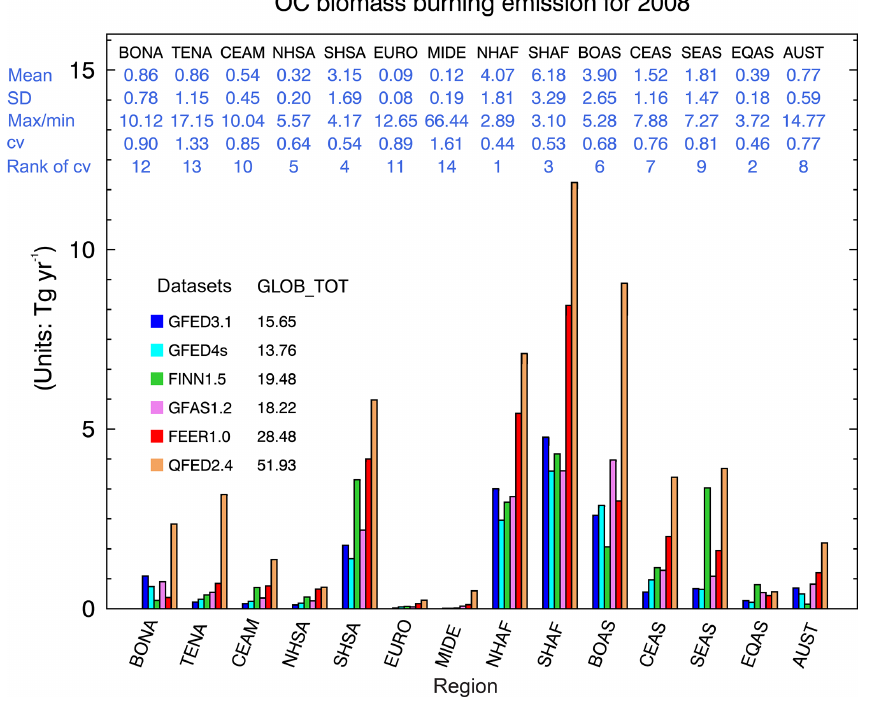
Figure 3. The regional annual total organic carbon (OC) biomass burning emissions for 2008 in six biomass burning emission datasets in 14 regions (units: Tgyr − 1 ). The global annual total amount is listed after the name of each dataset (GLOB_TOT). Relevant statistics for the six BB emission datasets in each region are also listed at the top of the panel in blue under the short name of each region, with the mean of the six BB emission datasets in the first row. Three different methods to measure the spread of the six BB emission datasets are shown as well: one absolute method, i.e., the standard deviation (SD) in the second row, and two relative methods, i.e., the ratio of max to min (i.e., maximum / minimum) shown in the third row, as well as the coefficient of variation (cv), defined as the ratio of the SD to the mean, in the fourth row. The rankings of the regions reflecting the spread of the BB emissions datasets according to cv are shown in the fifth row (i.e., a ranking of 1 means that this region shows the least spread among the six BB emissions datasets, while a ranking of 14 indicates that this region has the largest spread among the 14